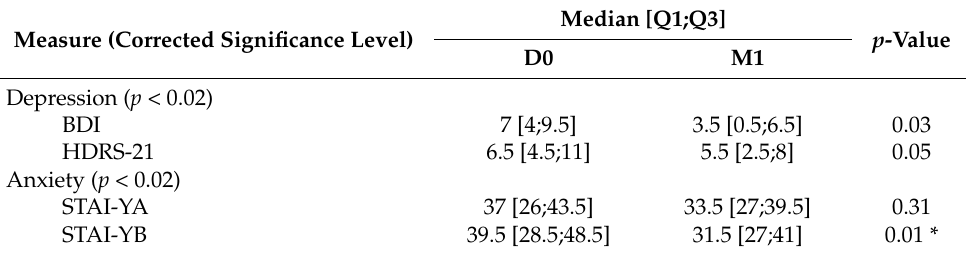
Table 4. Median values and quartiles [Q1;Q3] for pre- (D0) and 1-month post-10 rTMS sessions (M1) measures with p